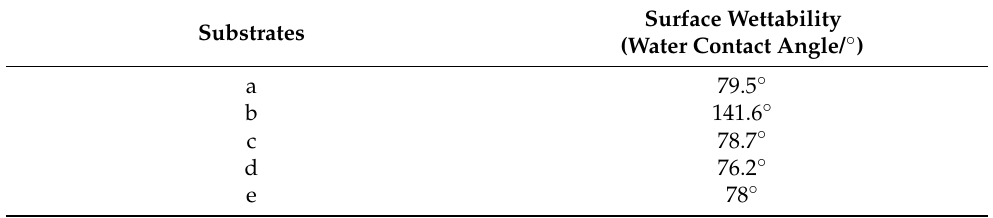
Table 1. The average water contact angle of ( a ) groove pattern; ( b ) micro-hole pattern; ( c ) directional grain pattern; ( d ) stripe pattern ( e ) control